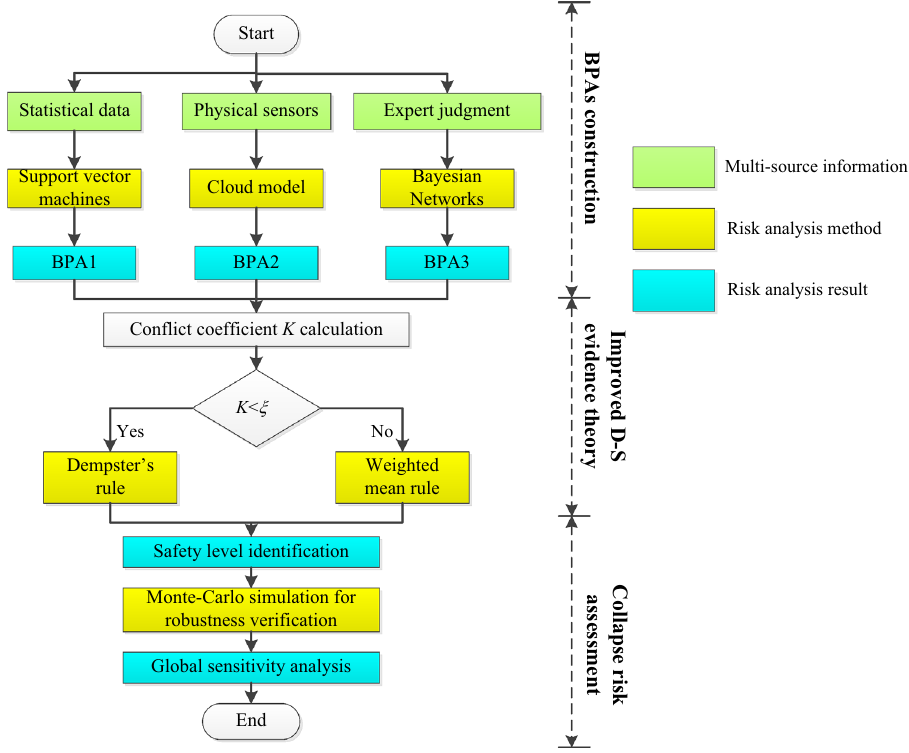
Figure 1. Flowchart of the proposed hybrid method for multi-source information fusion